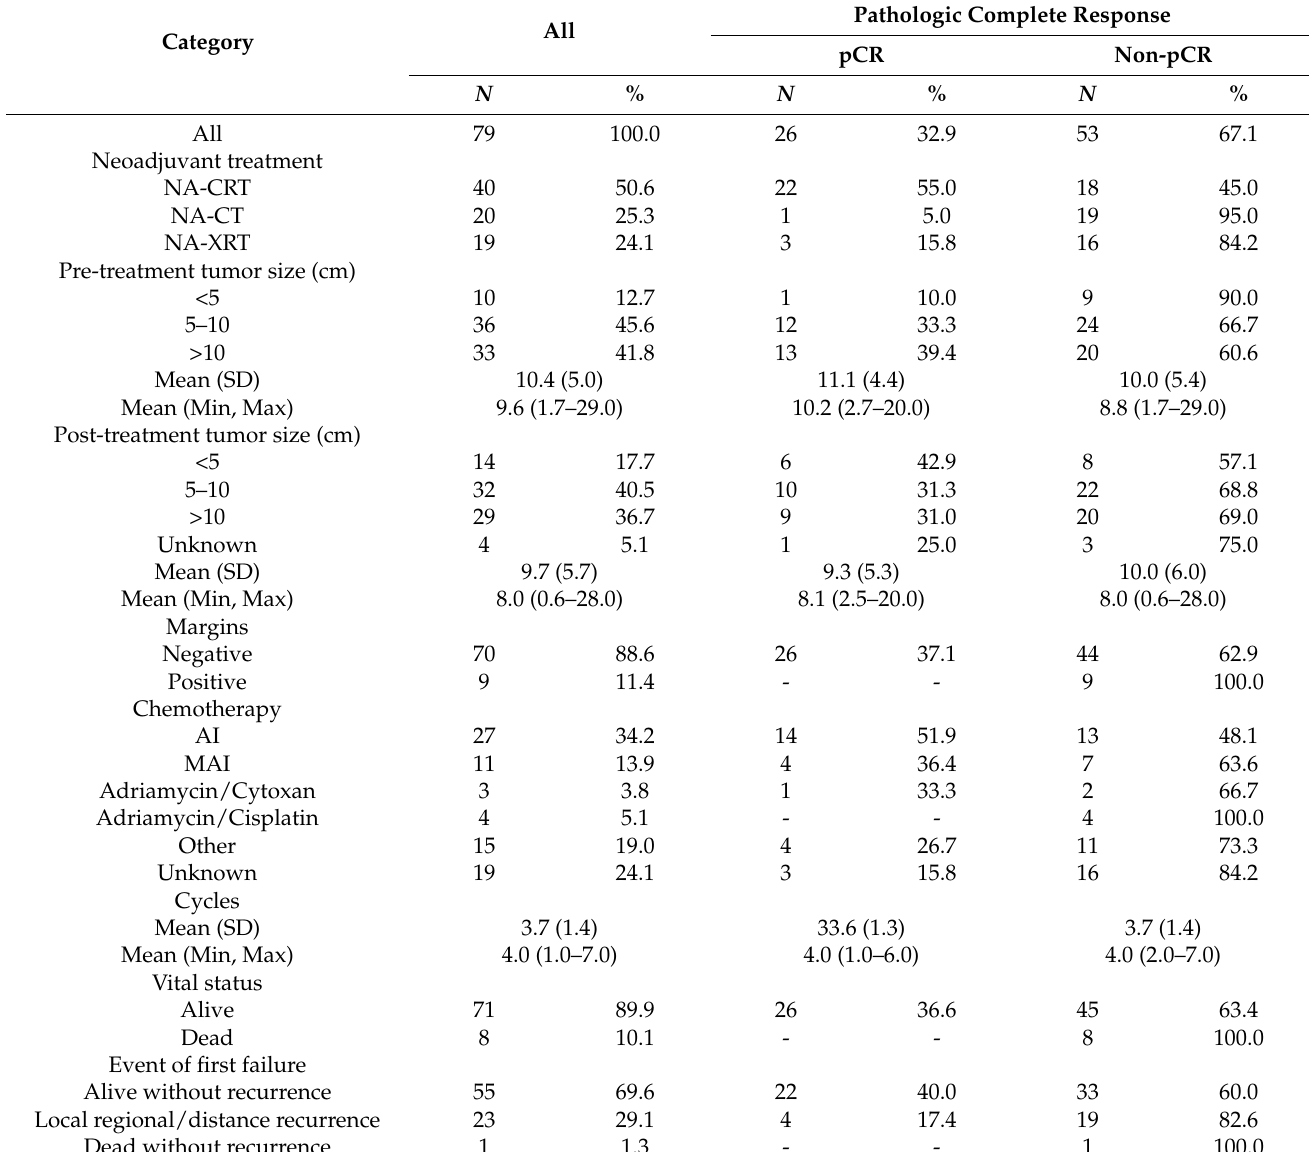
Table 2. Treatment and response